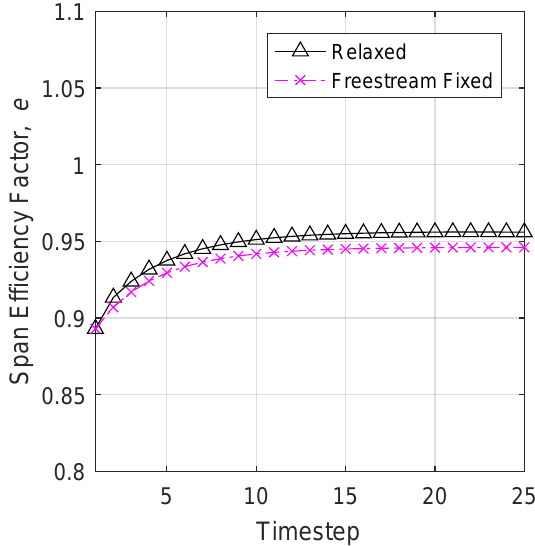
Figure 6. Relaxed and fixed wake predictions of span efficiency as the number of time steps increases for a rectangular